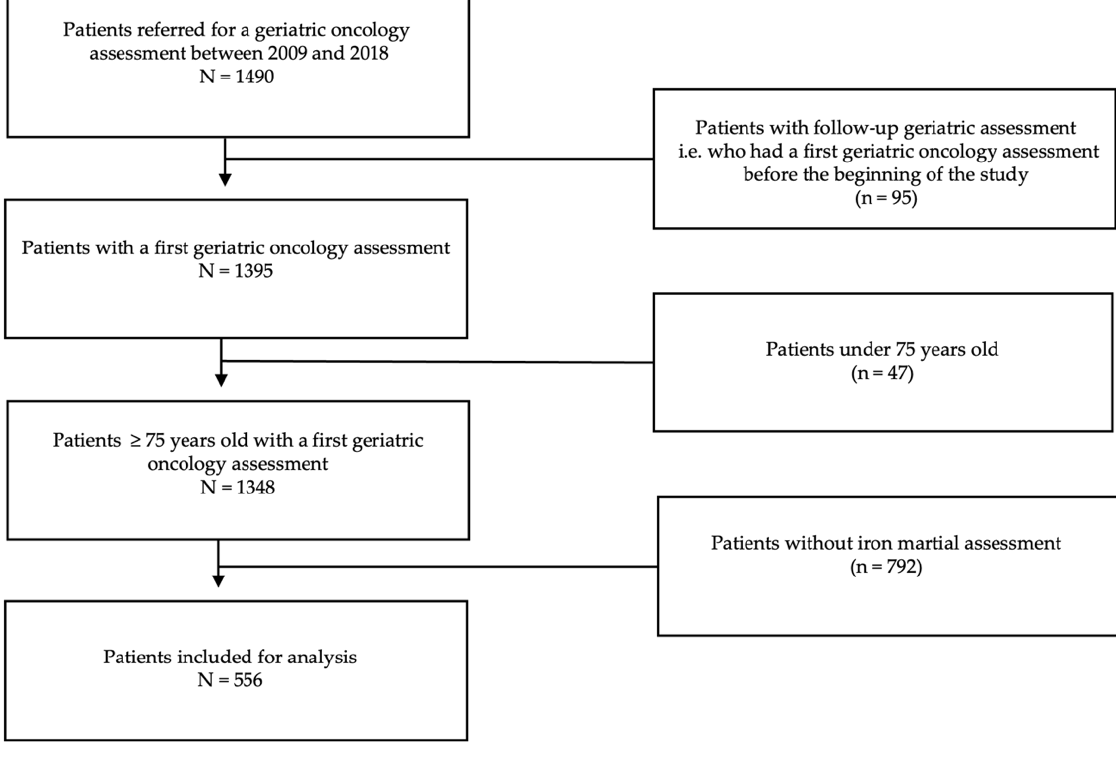
Figure 1. Flow chart. Figure 1. Flow Table 1. Patient characteristics at baseline.